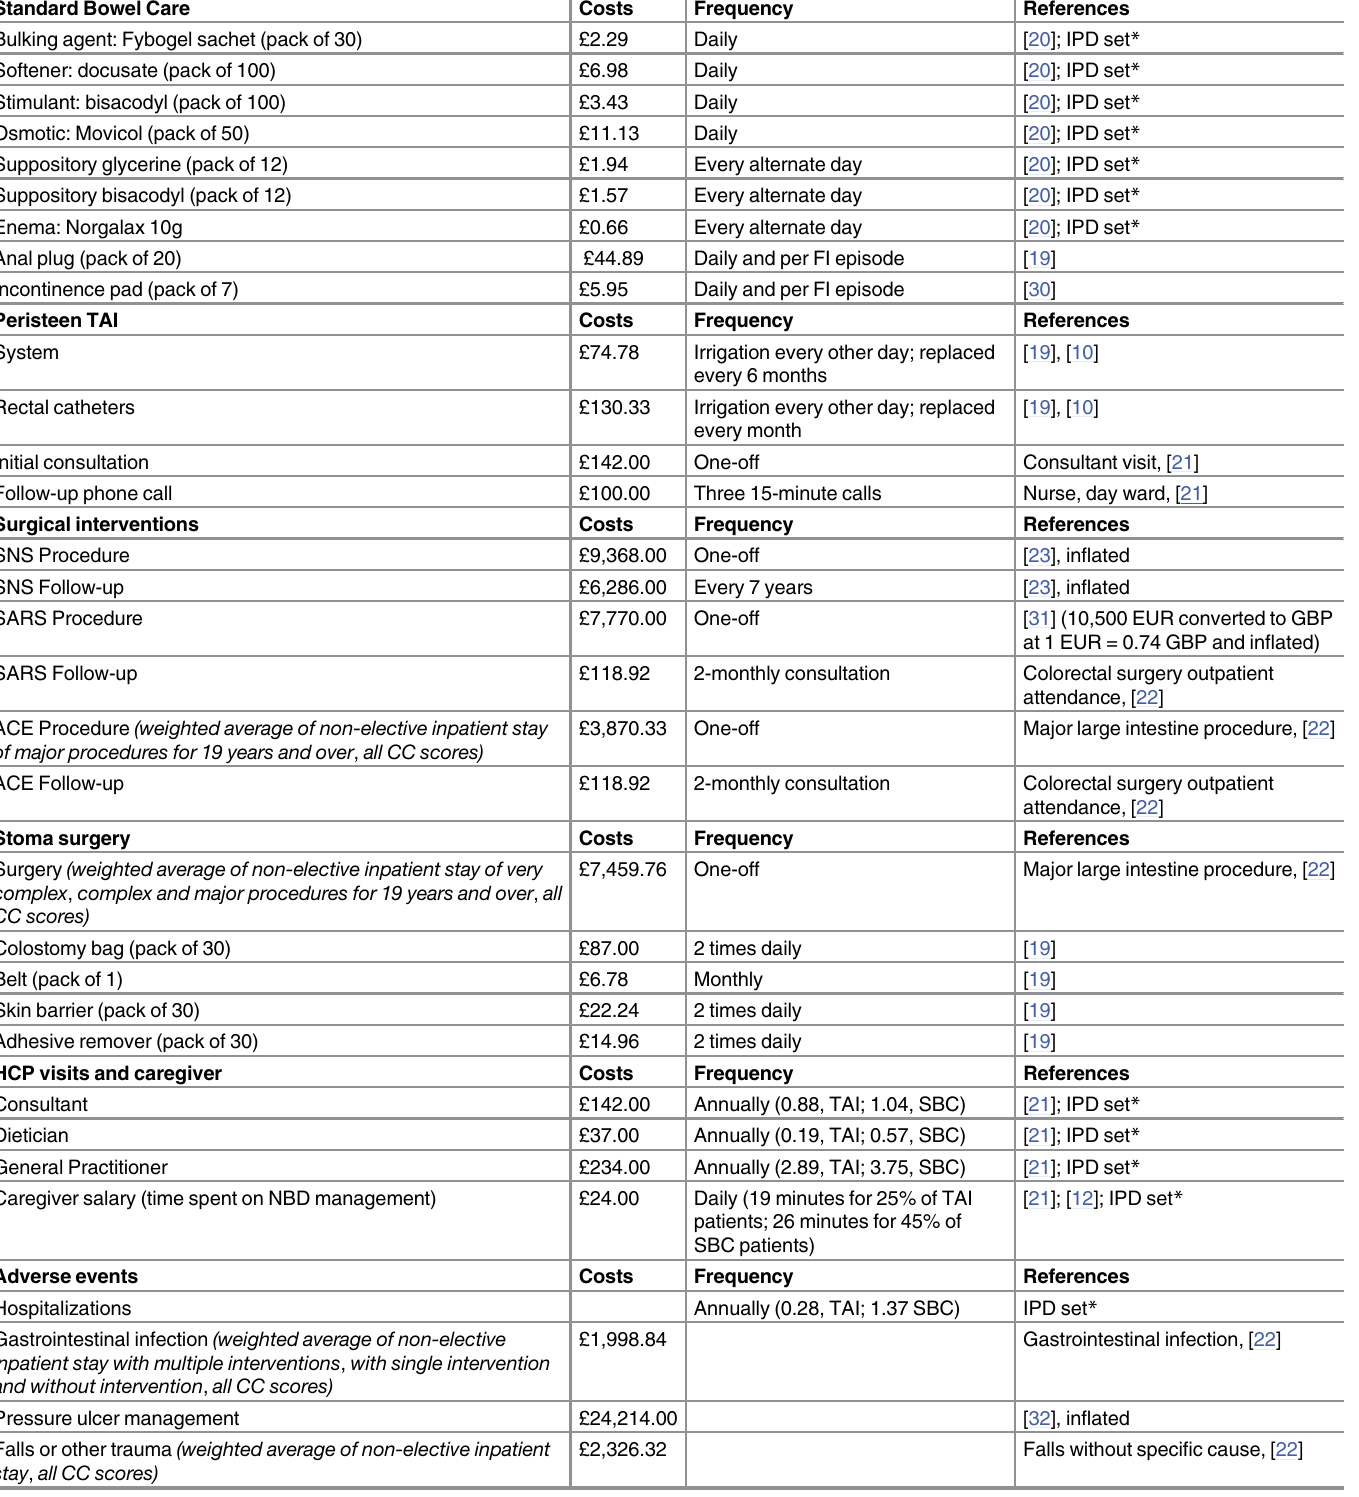
Table 4. Costs and resource